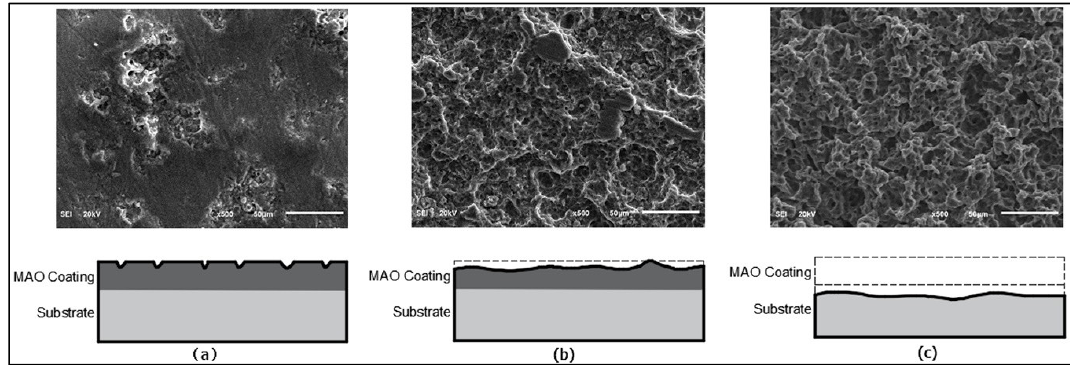
Figure 6. The typical progress of erosion with SEM micrographs of the MAO-2 sample after various test times. ( a ) 2.5 min; ( b ) 5 min; ( c ) 10 min. Table 3. Weight concentration (wt.%) of MAO coating surfaces before and after test.